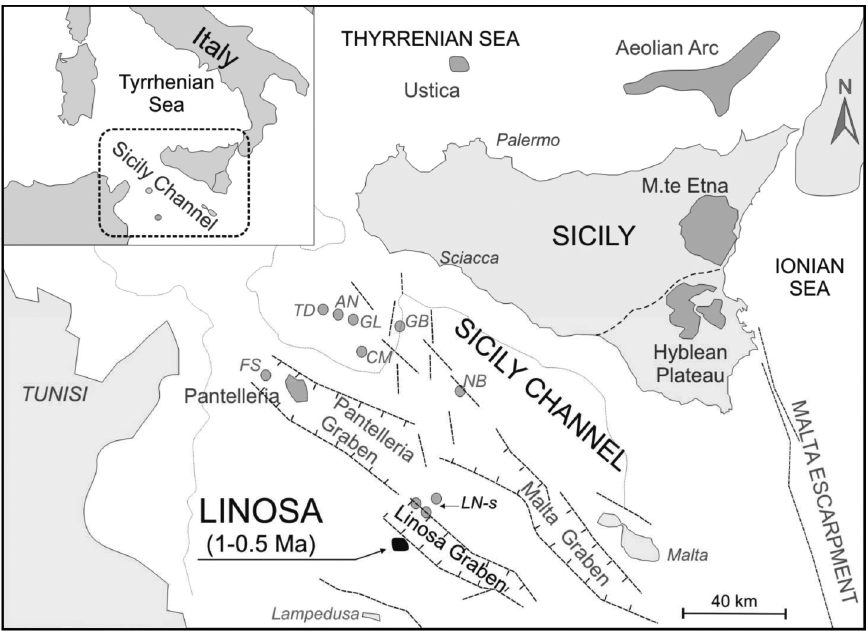
Figure 1. Geographic sketch of the Sicily Channel Rift with the location of Linosa island (fully black). The main regional volcanic manifes- tations are also reported (heavy grey); seamounts: AN = Anfitrite; CM = Cimotoe; FS = Foerstner; GB = Graham Bank; GL = Galatea; LN- S = Linosa-seamounts; NB = Nameless Bank; TD =